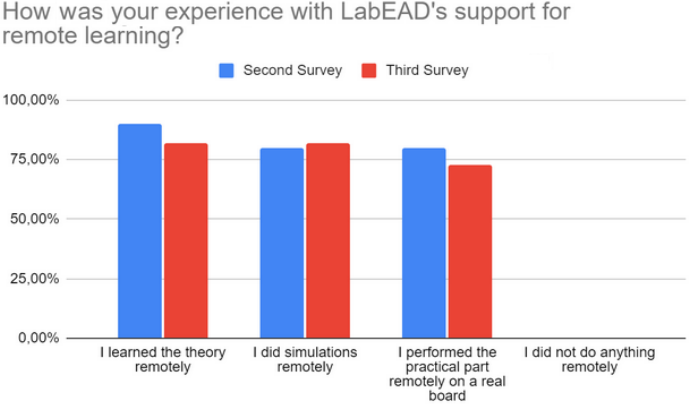
Figure 6. LabEAD support for remote learning as perceived by students.